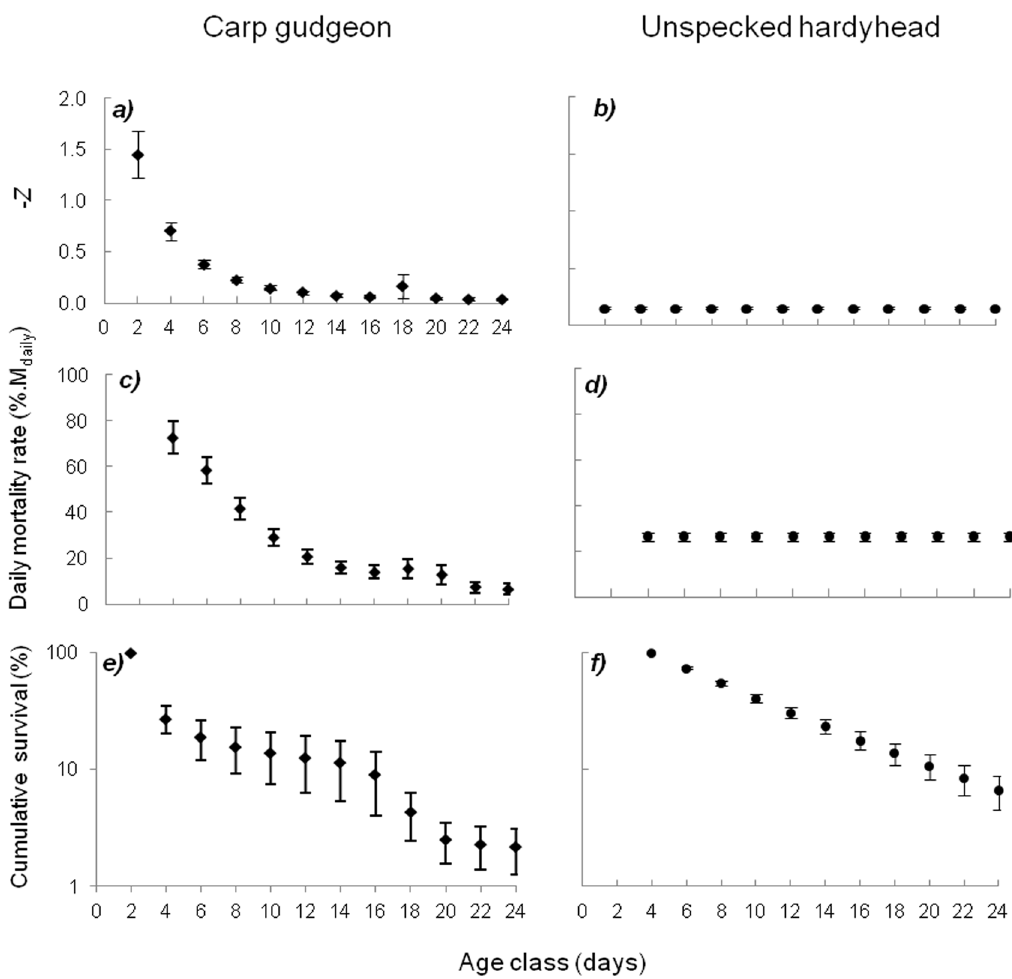
Figure 5. Mean ( ± SE) cohort; instantaneous mortality rates (- Z ), daily mortality rates (M daily ) and cumulative survival (%) of carp gudgeon and unspecked hardyhead larvae. Age class (days) represent 2 day groupings of larvae (e.g. 2=1–2 day old larvae, 4=3–4 day old larvae etc).